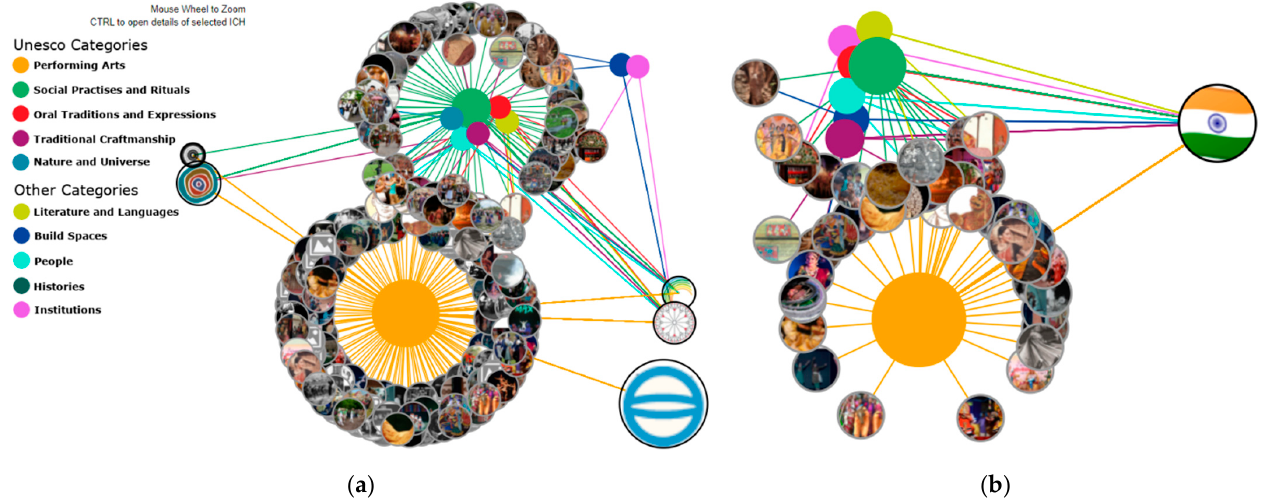
Figure 13. Results for theme “Traditional dances” by force graph: ( a ) view selected is “Source- Domain-ICH”; ( b ) refinement with the key “India” from filters.